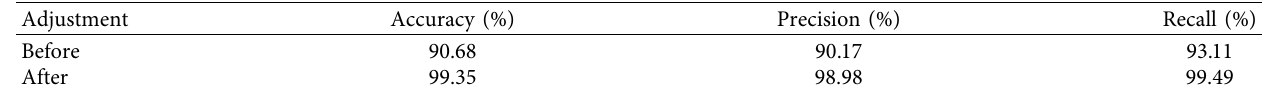
Table 5: The effect of the correction factor on the